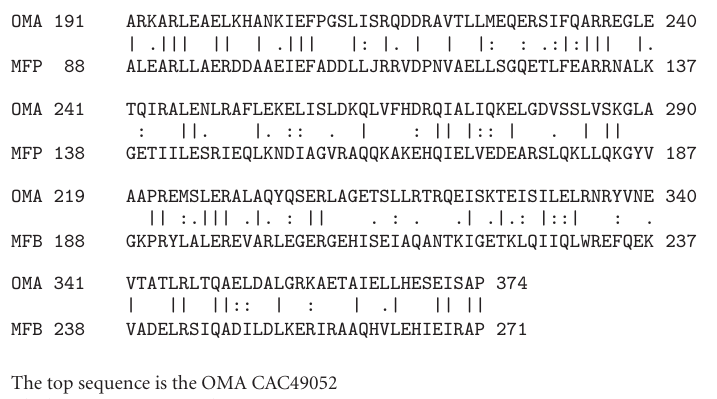
Figure 1: Alignment of a large portion of an OMA from Sinorhizobium meliloti (an α -proteobacterium) (top; CAC49052) with a homologous portion of an MFP from Nitrococcus mobilis (a γ -proteobacterium) (bottom; EAR21905). Only OMA homologues from ∞ -proteobacteria were retrieved as top hits when this region of the OMA of S. meliloti was used as the query sequence in BLAST searches, while only MFP homologues were retrieved as top hits when this portion of the MFP of N. mobilis was used as the query sequence. All proteins retrieved in BLAST searches as top hits that were not from α -proteobacteria proved to be MFPs rather than OMAs when this region of the S. meliloti homologue was used as the query sequence. For the comparison shown, the GAP program with default settings and 500 random shu ffl es gave 30% identity, 41% similarity, 0% gaps, and a comparison score of 23 SD. These values are far in excess of the values needed to establish homology [3, 5, 20]. The regions of striking identity are between resides 191 and 374 in the OMA and between residues 88 and 271 in the MFP as shown. These are the α -helical regions of both proteins as indicated in Figure 3. Vertical lines, identities; double and single dots, close and distant similarities as defined by the GAP program, respectively. Numbers at the beginning and end of each line of the two aligned sequences refer to residue numbers in the proteins.